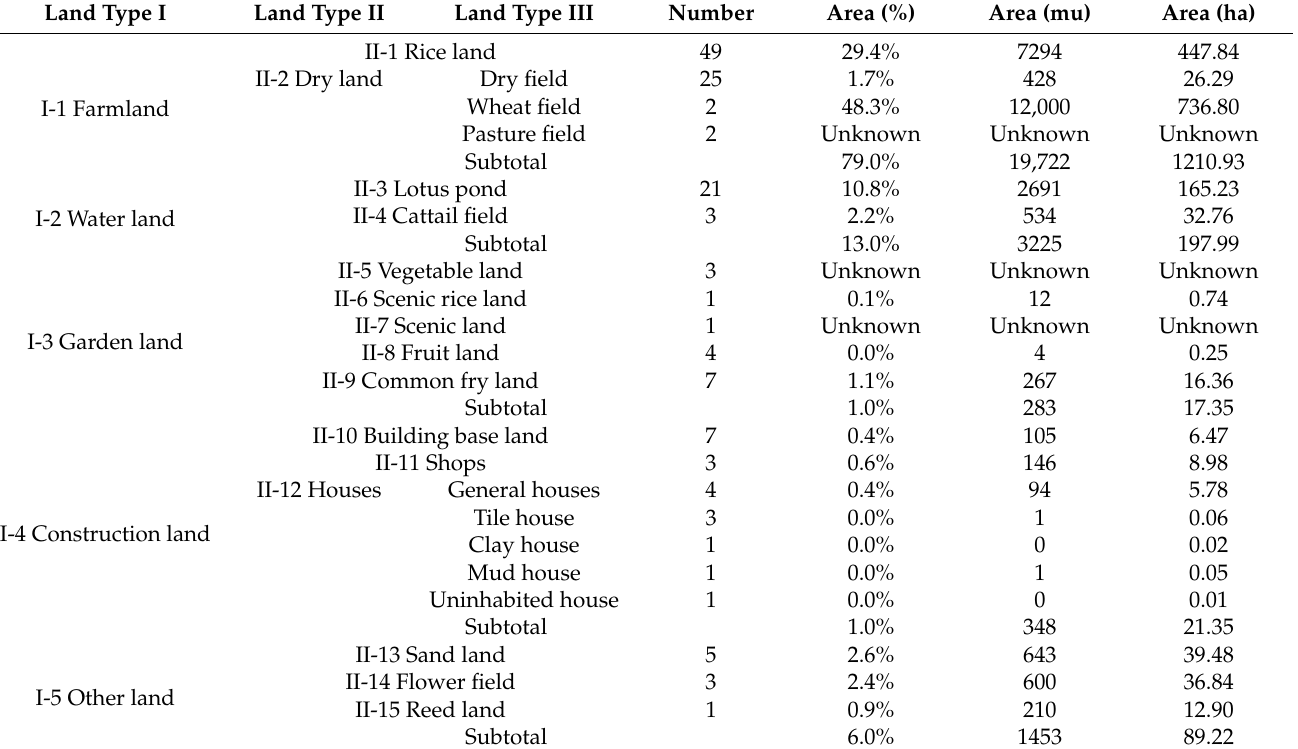
Table 1. Statistical chart of royal land use types